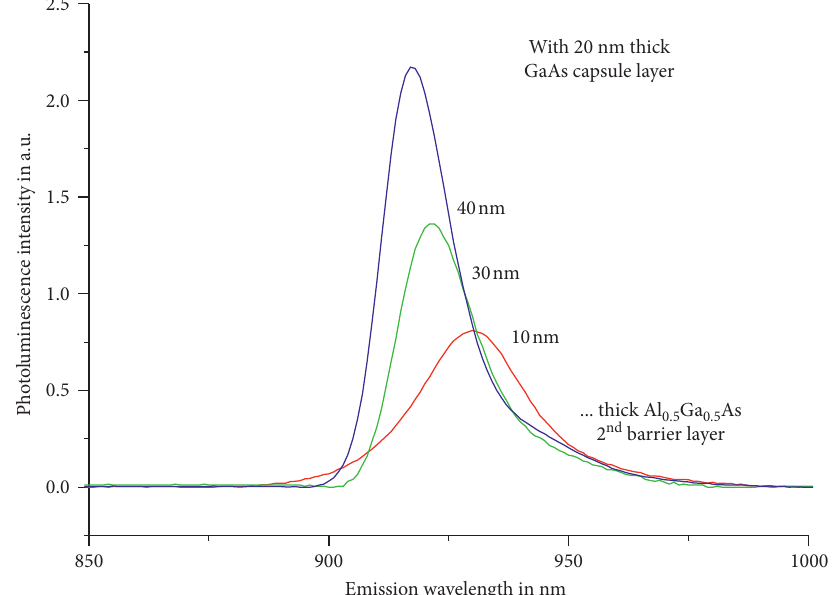
Figure 8: Results of photoluminescence (PL) measurements for three different samples, each with 4 QD layers, but double-layer barriers. Each barrier is made from a 20nm thick GaAs capsule layer and an Al 0.5 Ga 0.5 As layer of either one of three possible thicknesses, that is, 10nm, 30nm, and 40nm. The QD layers have been grown as described for the samples shown in Figure